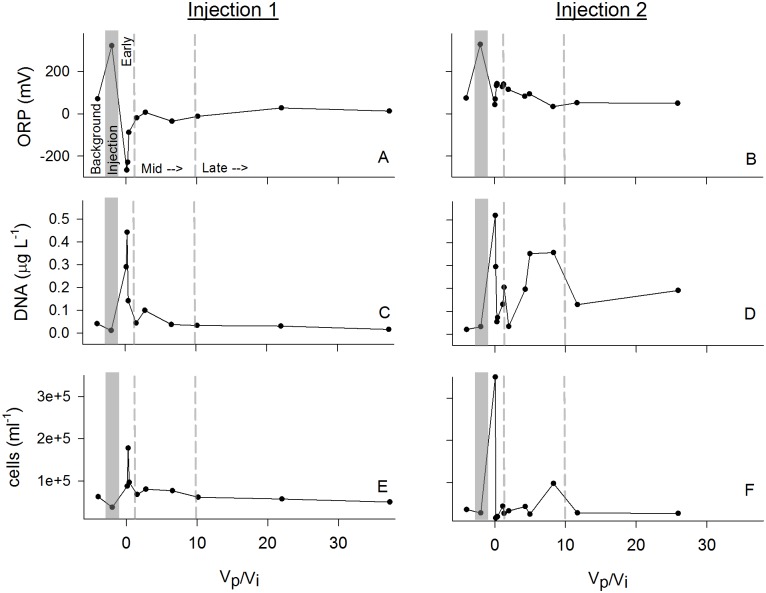
Biological parameters.Biological parameter concentrations over the course of the in-situ injection experiment. Vp/Vi = Volume pumped/Volume injected, with greater ratios representing longer incubation and more greater dilution of injection fluids. Injection 1 on the left (A, C, E, G), and Injection 2 on the right (B, D, F, H). As in Fig. 1, dashed and shaded lines on the x-axis separate: “Background” pre-injection conditions; “Injection” fluids prior to in situ incubation; “Pumpback” of fluids following in situ incubation during the Early, Mid, and Late phases.